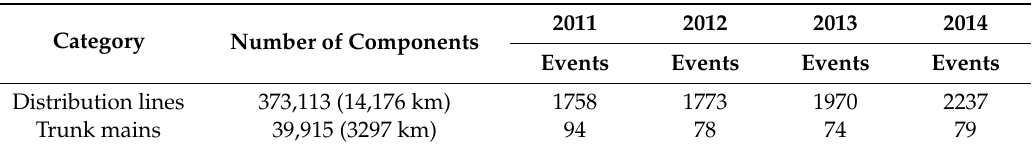
Table 1. Analyzed